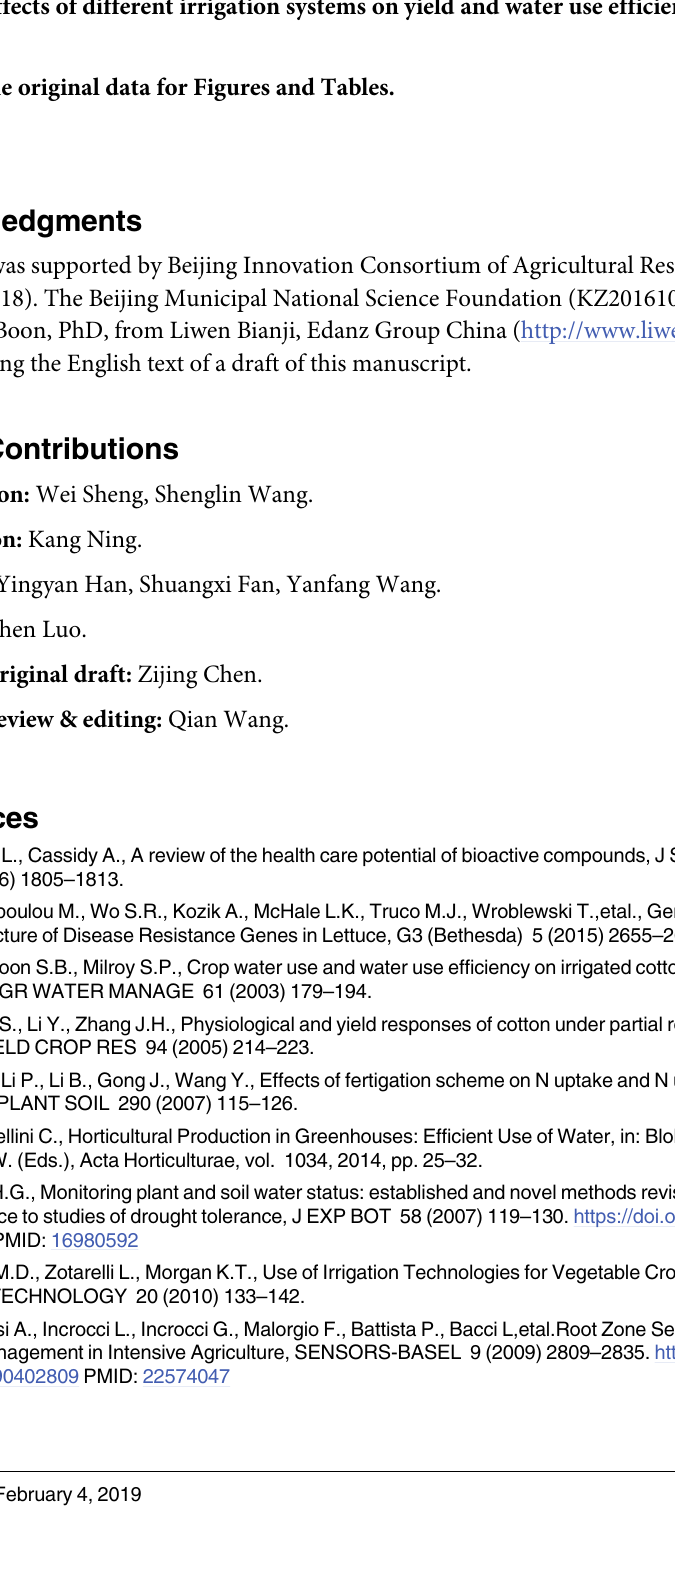
S6 Table. Effects of different irrigation systems on whole plant weight, aboveground and underground weight (g/plant). S7 Table. Effects of different irrigation systems on nutrient absorption (g/ plantD � W). (PDF) S8 Table. Effects of different irrigation systems on yield and water use efficiency.